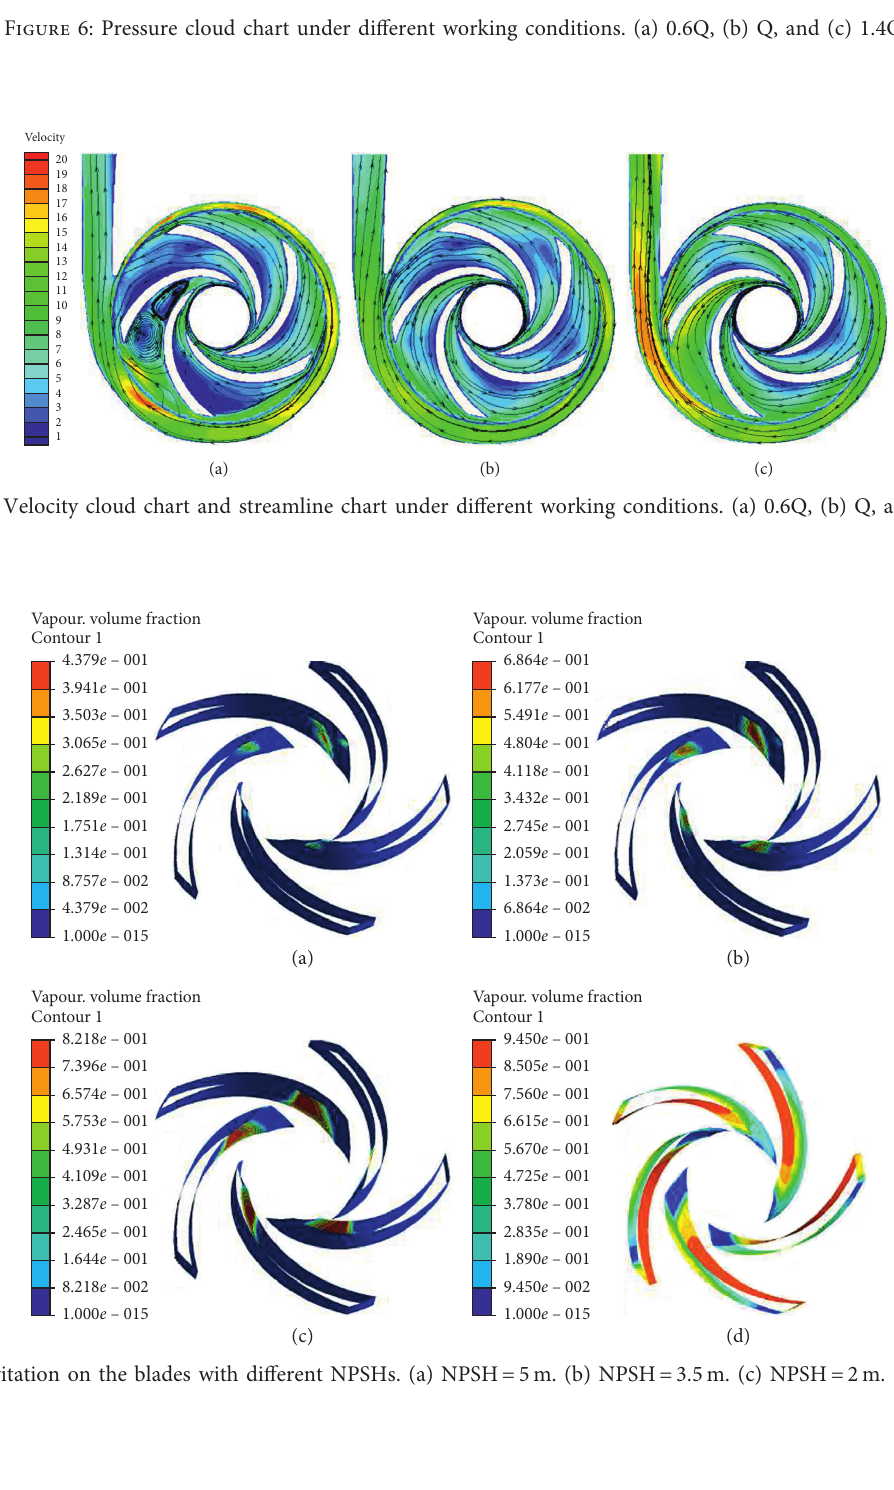
Figure 8: Cavitation on the blades with different NPSHs. (a) NPSH � 5m. (b) NPSH � 3.5 m. (c) NPSH � 2m. (d) NPSH � 1